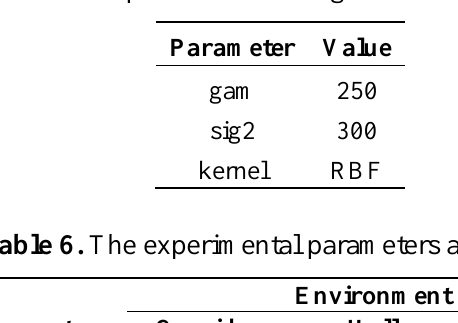
Table 5. The parameters setting of LS-SVM method.